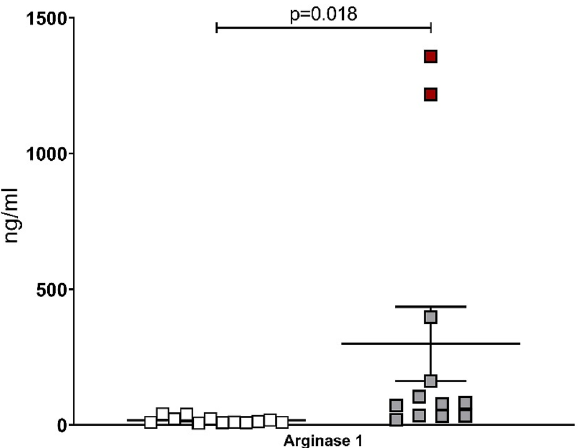
Figure 3. Arginase 1 concentration (ng/ml) in serum of L-ZSF1 (left side) and O-ZSF1 (right side). Boxplots visualize the median, 25th and 75th percentiles and minimum/ maximum. Two samples of the O-ZSF1 group indicated with red boxes were excluded for p-value calculation that was done using Kruskal–Wallis test.